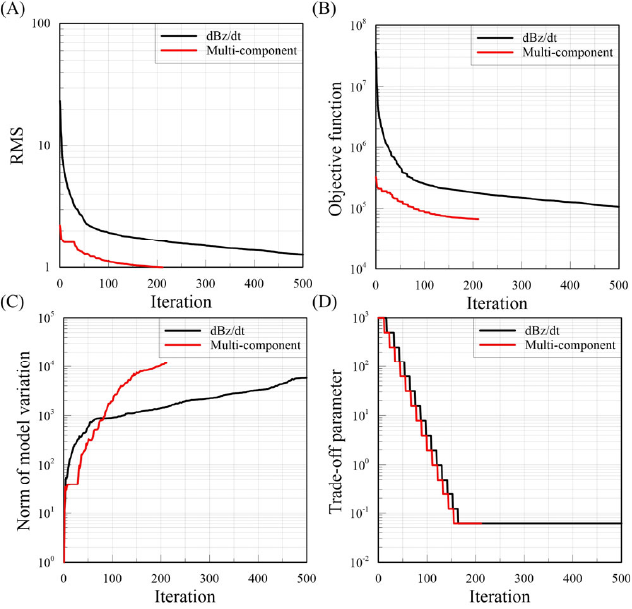
Figure 8. Inversion parameter versus iterations for the inclined ore body model. ( A ) is the RMS ( B ) is the objective function ( C ) is the norm of model variation and ( D ) is the trade ‐ off parameter.